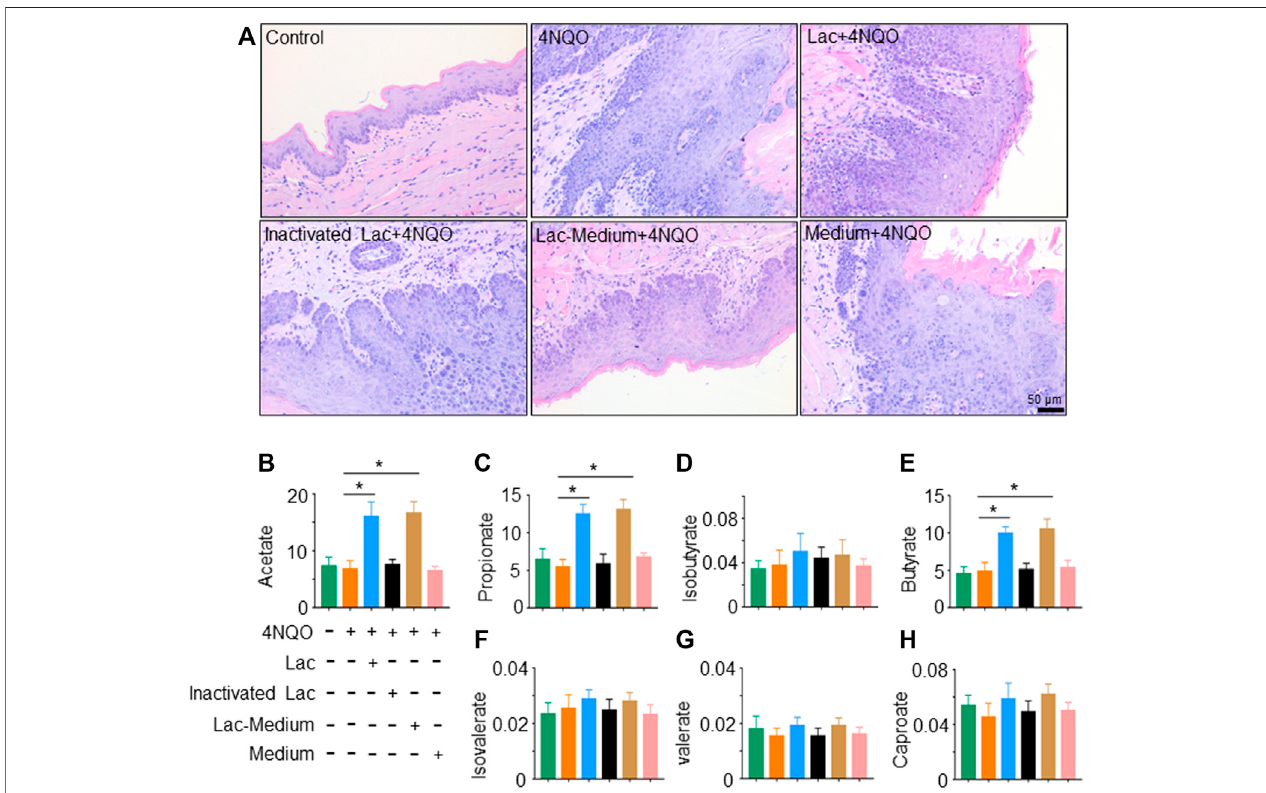
FIGURE 4 | Viable Lactobacillus is necessary for delaying OPC tumorigenesis. Lactobacillus was inactivated by pasteurization for 30 min at 70 ° C. After pasteurization, no viable Lactobacillus could be recovered in culture. 2 × 10 9 CFU of Lactobacillus , inactivated Lactobacillus , Lactobacillus culture supernatant (Lac-Medium) or Medium alone was dripped into mouth of mice treated with 4NQO for 16 weeks. SCFAs in glossopharyngeal tissue of the mice were quanti fi ed as describedinMaterialsandMethods. (A) HEstainingofglossopharyngealtissue. (B – H) Levels(µg/ml)ofacetate,propionate,isobutyrate,butyrate,isovalerate, valerate, and caproate in glossopharyngeal tissue of the mice. Data represent mean ± SEM. * p < 0.05, n = 5, compared with 4NQO alone.